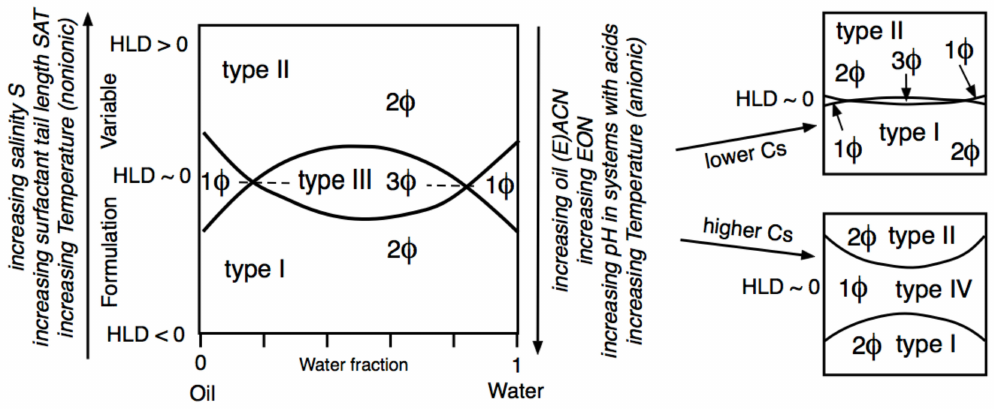
Figure 14. Phase behavior in the formulation-WOR cut of the 3D prism shown in Figure